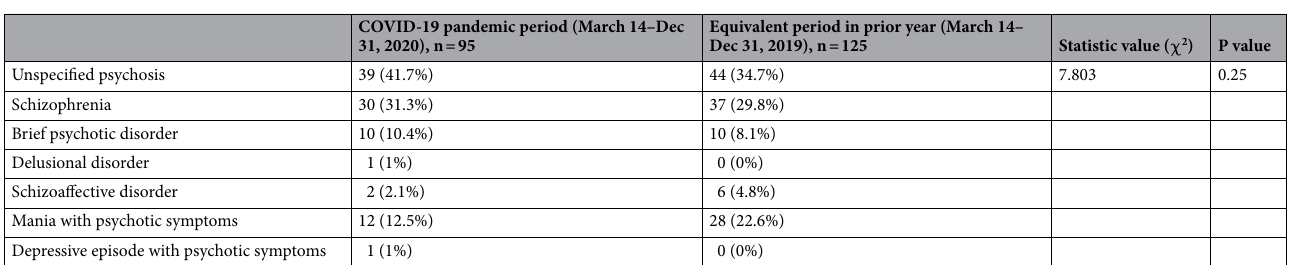
Table 1. Diagnosis subtypes of the two groups of FEP patients.